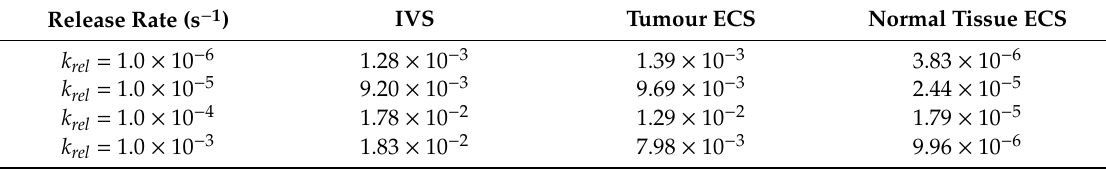
Table 5. AUC 24h (mg/mL·s) of the treatments using liposomes with different release rates.